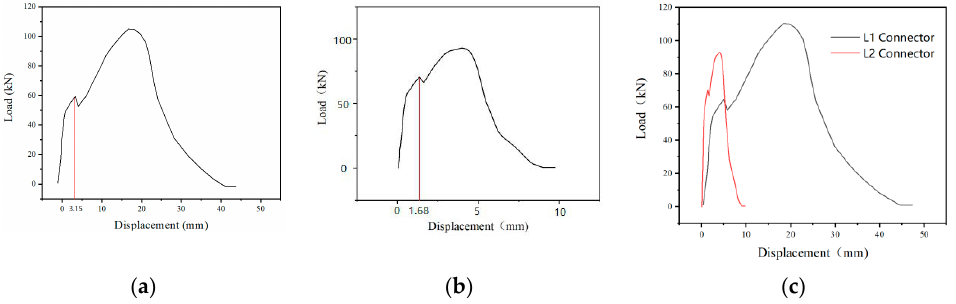
Figure 12. Load–displacement curve of connector. ( a ) L1 connector; ( b ) L2 connector; ( c ) L1 and L2